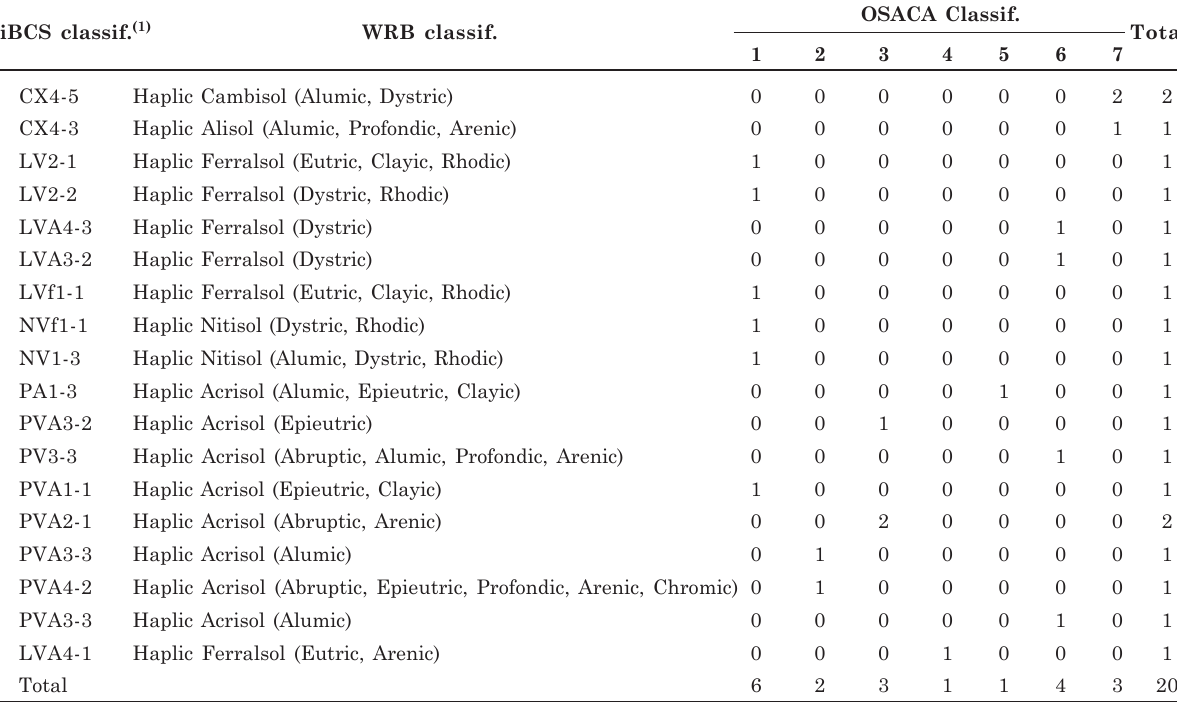
(1) Nomenclature according to Embrapa (2013). The first number following the soil class represents the textural class: (1) heavy clay: > 60 %; (2) clay: > 35 % and 60 %; (3) clay loam: > 25 % and 35 %; (4) sandy loam: >15% and 25 %; and (5) sand: 15 %. The second number represents the diagnostic chemical properties: (1) Bsat 50 %; (2) Bsat < 50 %; (3) Alsat 50